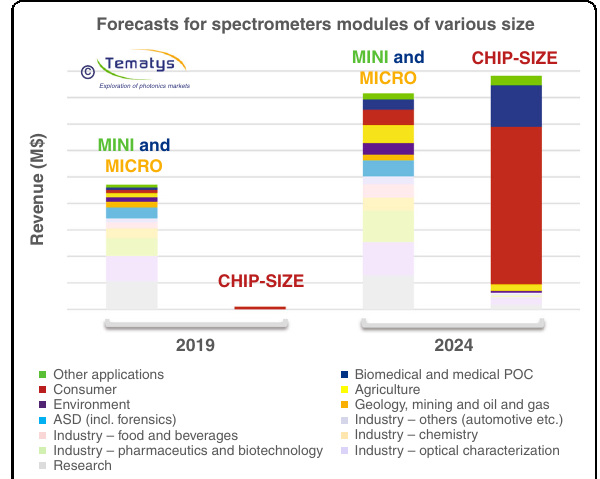
Fig. 2 Forecasts for spectrometer modules of various sizes. Reprinted from ref. 27 with permission from